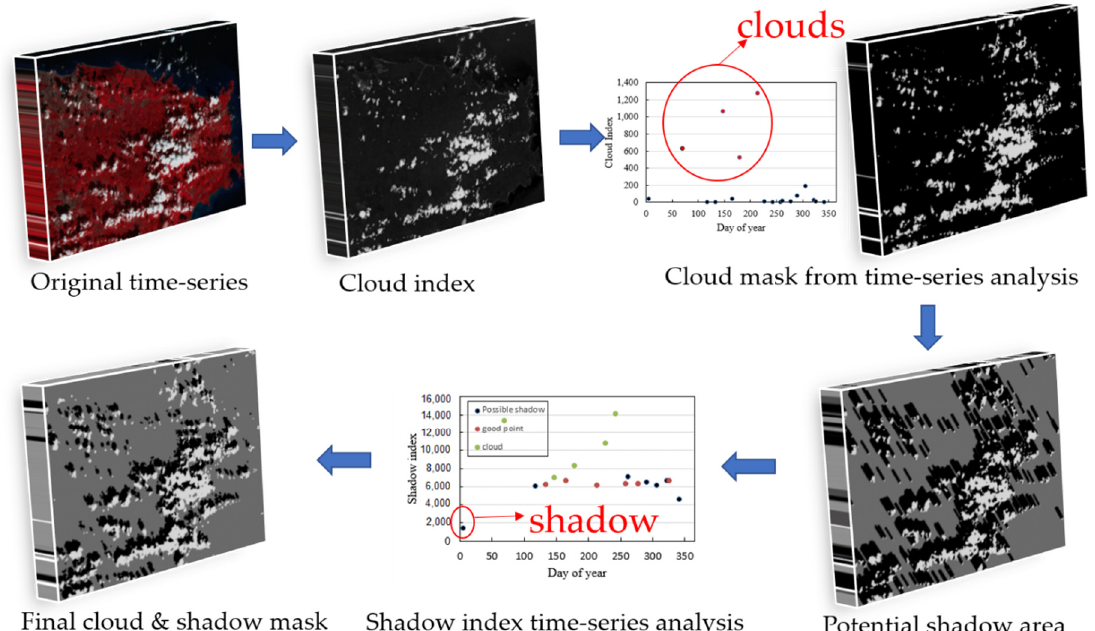
Figure 3. Principle and process of ATSA for screening clouds and shadows in Landsat time series (the reflectance value of pixels was rescaled to 0–10,000 for computing cloud and shadow indices).